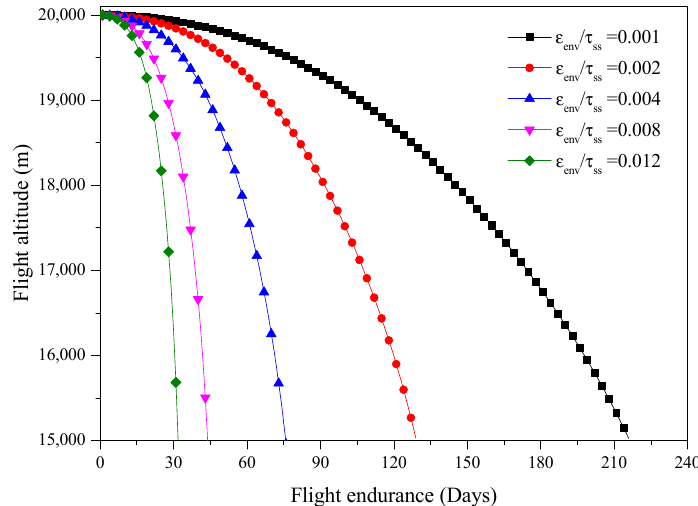
ε τ / Figure 9. Effects of ε env / τ ss on the flight altitude of near-space aerostats. Figure 9. Effects of on the flight altitude of near-space aerostats. env ss In order to evaluate the effects of ε env / τ ss on the diffusion coefficient of an envelope, a series of values for the ratio of porosity to tortuosity were considered. The variation in the diffusion coefficient with ε env / τ ss is shown in Figure 10. The results showed that with increases in the flight endurance, the diffusion coefficient decreases. The diffusion coeffi- cient was found to decrease with ε env / τ ss due to an increase in the molecular diffusivity. If ε env / τ ss becomes larger, the diffusion coefficient decreases faster.